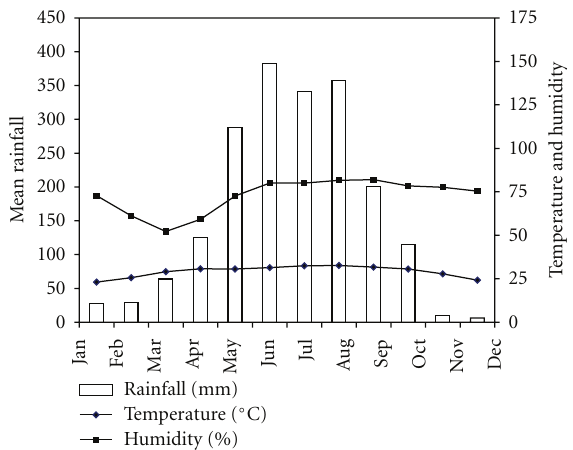
Figure 2: Ombrothermic diagram (Precipitation scale = 2 × Temperature scale) for the study area (mean of years 2001– 2005). The relative humidity is also plotted on the same axis as